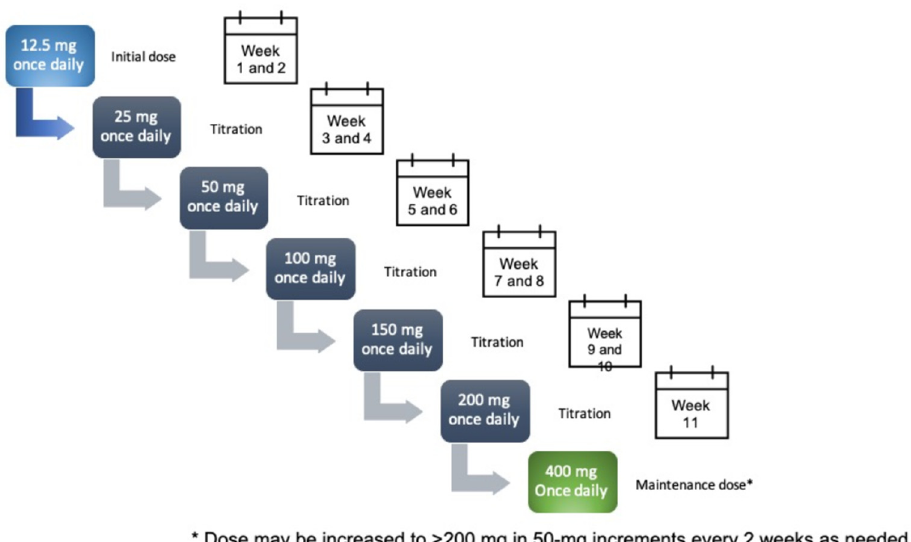
Figure 5. FDA-approved cenobamate dosing schedule for focal onset seizures.